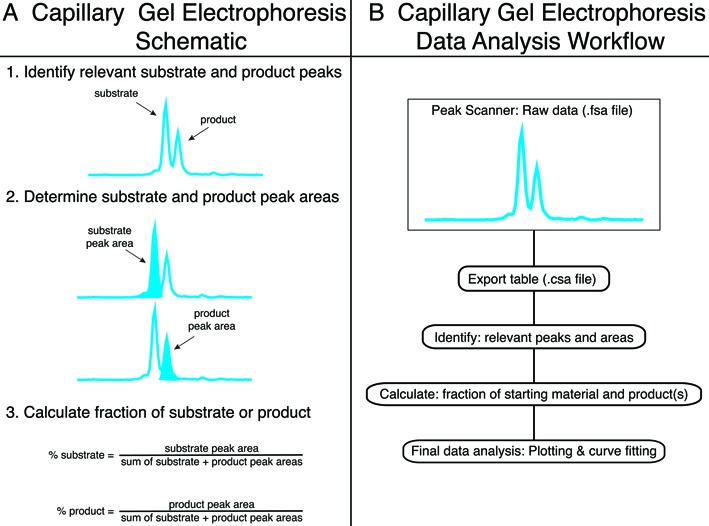
Capillary gel electrophoresis data analysis workflow. The CE data analysis workflow is illustrated schematically in panels (A) and (B). (A) Fluorescent reactions are resolved and detected by CE to identify substrate and product peaks. Next, peak areas are determined and fractions of substrate and products are calculated. (B) Peak Scanner software generates a raw CE data file (.fsa) that can be exported as a table (.csa file). Standard spreadsheet software can be used to extract peaks and areas, and to calculate fractions of substrates and products. Statistical graphic software is then used for final data analysis including plotting and curve fitting.